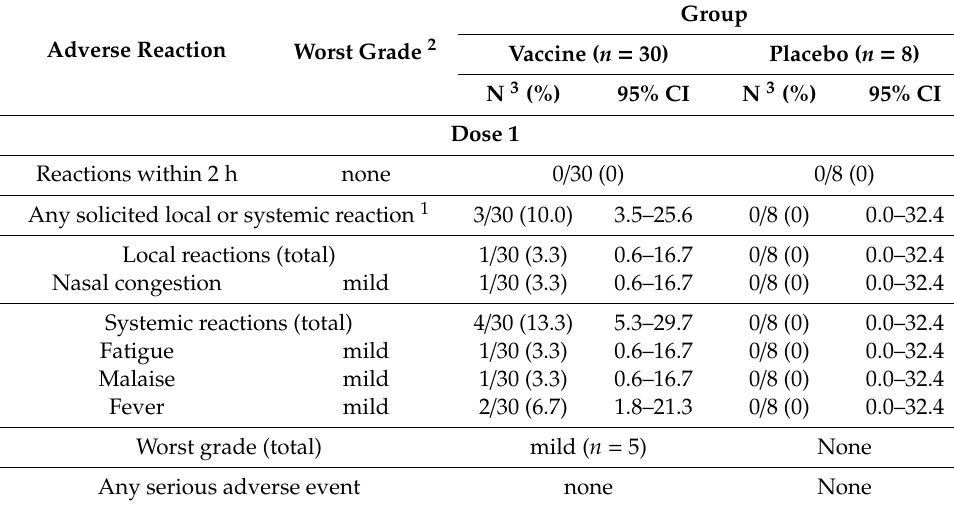
Table 2. Adverse reactions in the 6 days after vaccination or